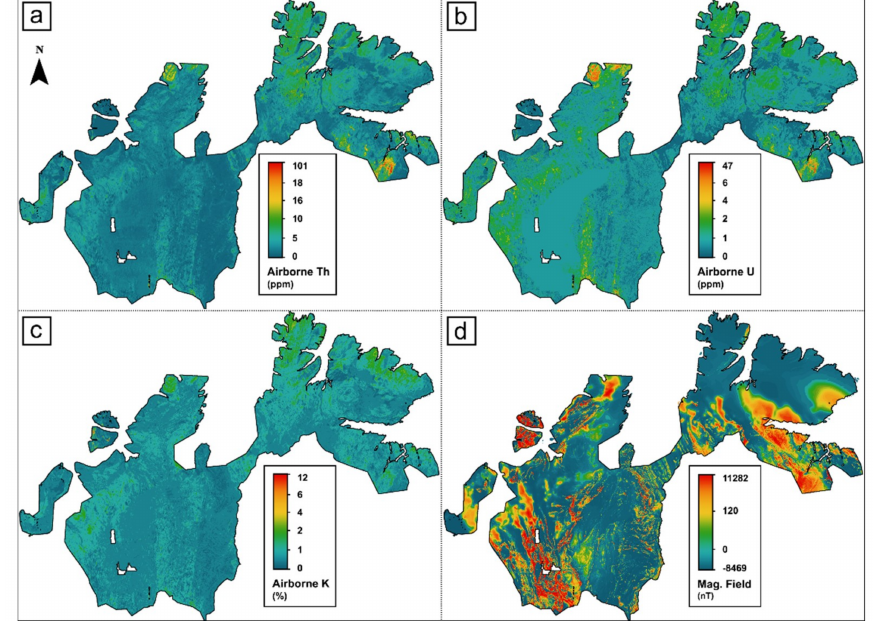
Figure 3. Maps amplitude of ( a ) thorium (Th), ( b ) uranium (U), ( c ) potassium (K) and ( d ) total magnetic field.